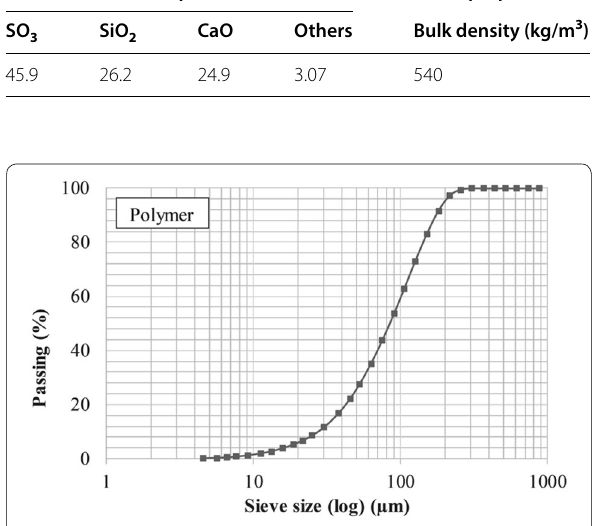
Fig. 6 Particle size distribution of the polymer